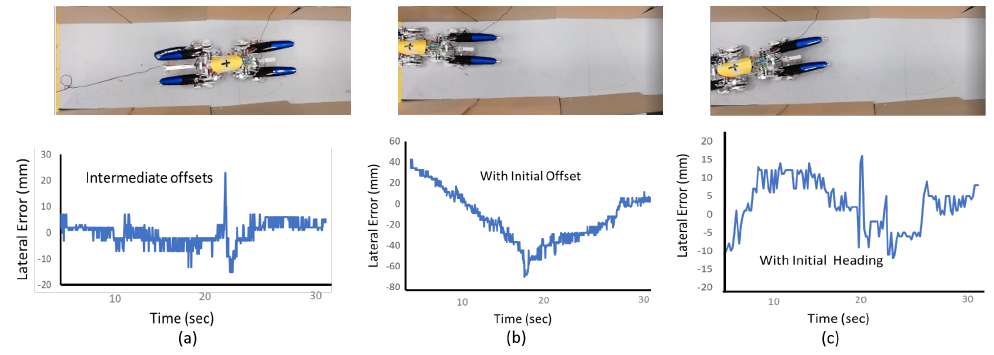
Figure 20. Wall following experiments for an ( a ) intermediate offset, ( b ) initial offset, and ( c ) initial heading error of the wall.